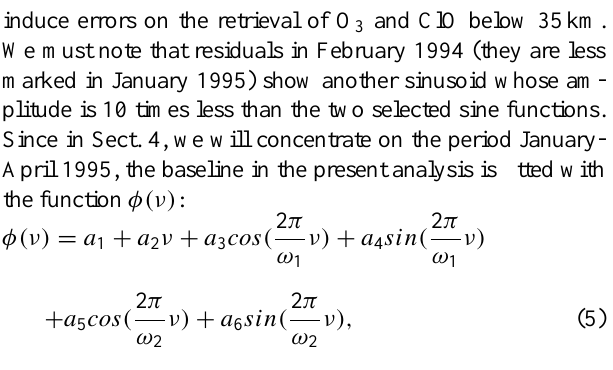
Fig. 3. Upper: Baseline (arbitrary unit) measured in February 1994 (thin line) and fit of the signal over the 1-MHz channels with sine functions (thick line). Lower: Residual between the fit and the mea- sured baseline over the 1-MHz channels. Note that the retrieved am- plitude of the baseline ripples is typically ranging from 5 to 20mK.